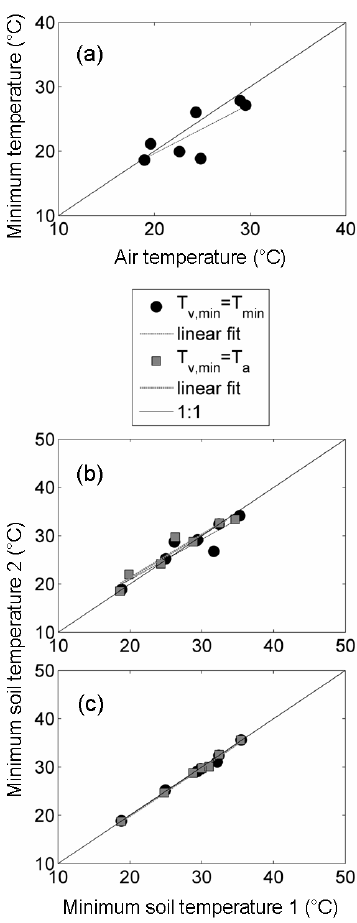
Fig. 3. T min is plotted versus T a (a) , and T s,min,1 and T s,min,2 are intercompared for both T v,min = T min and T v,min = T a cases, and for f vg,TSMIN =0.5 (b) and daily optimized f vg,TSMIN (c) separately.